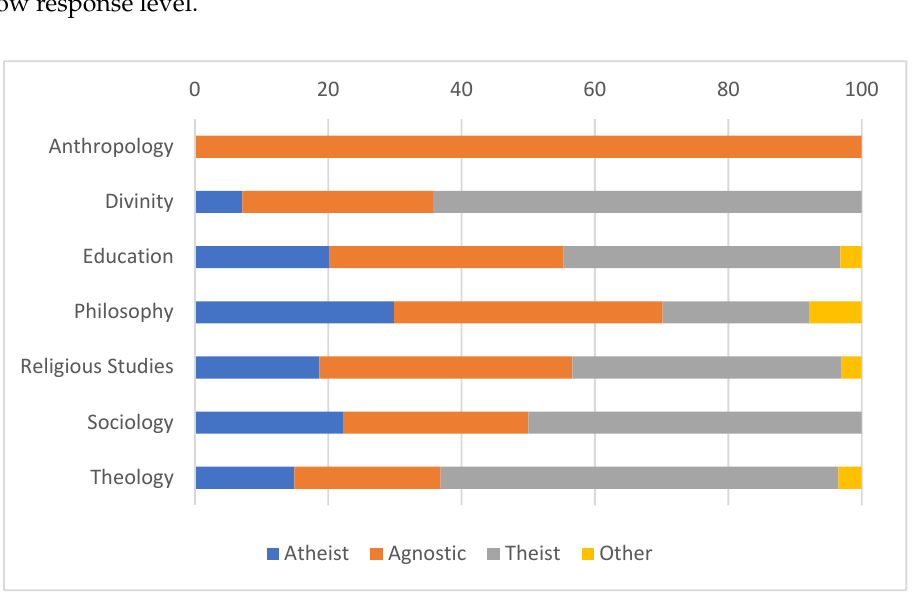
Figure 5. Cross-tabulation of degree background Q6 and Q15 Concerning belief in God(s), are you? (England, Scotland and Secondary only [%]): n = 308.